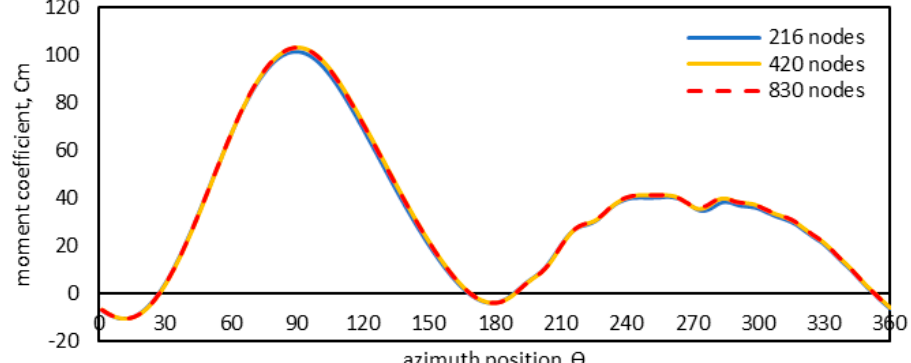
Figure 8. Node density study for the validation case.